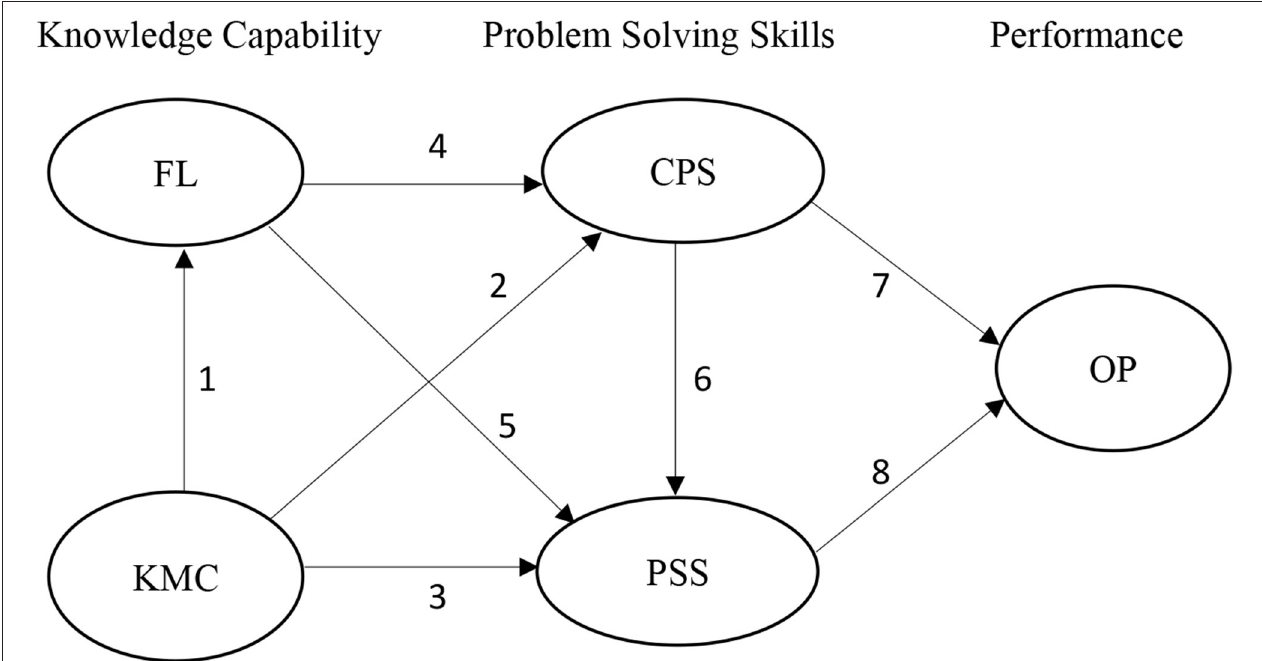
FIGURE 1 | Small and medium enterprises (SME) performance improvement model. Source: Developed by